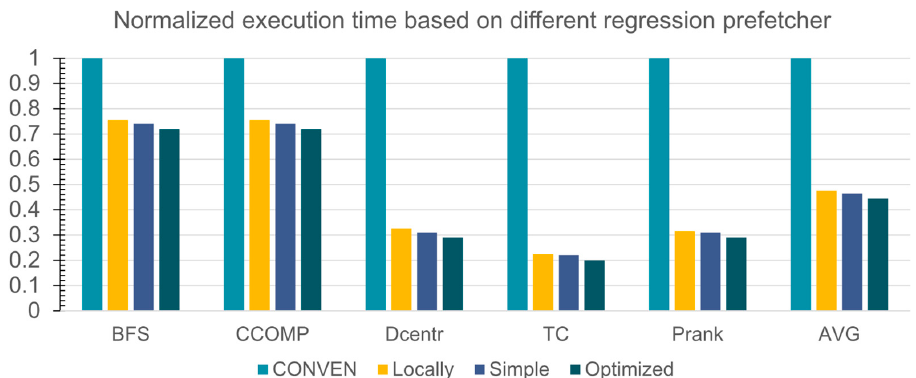
Figure 10. Execution time for different regression prefetchers.